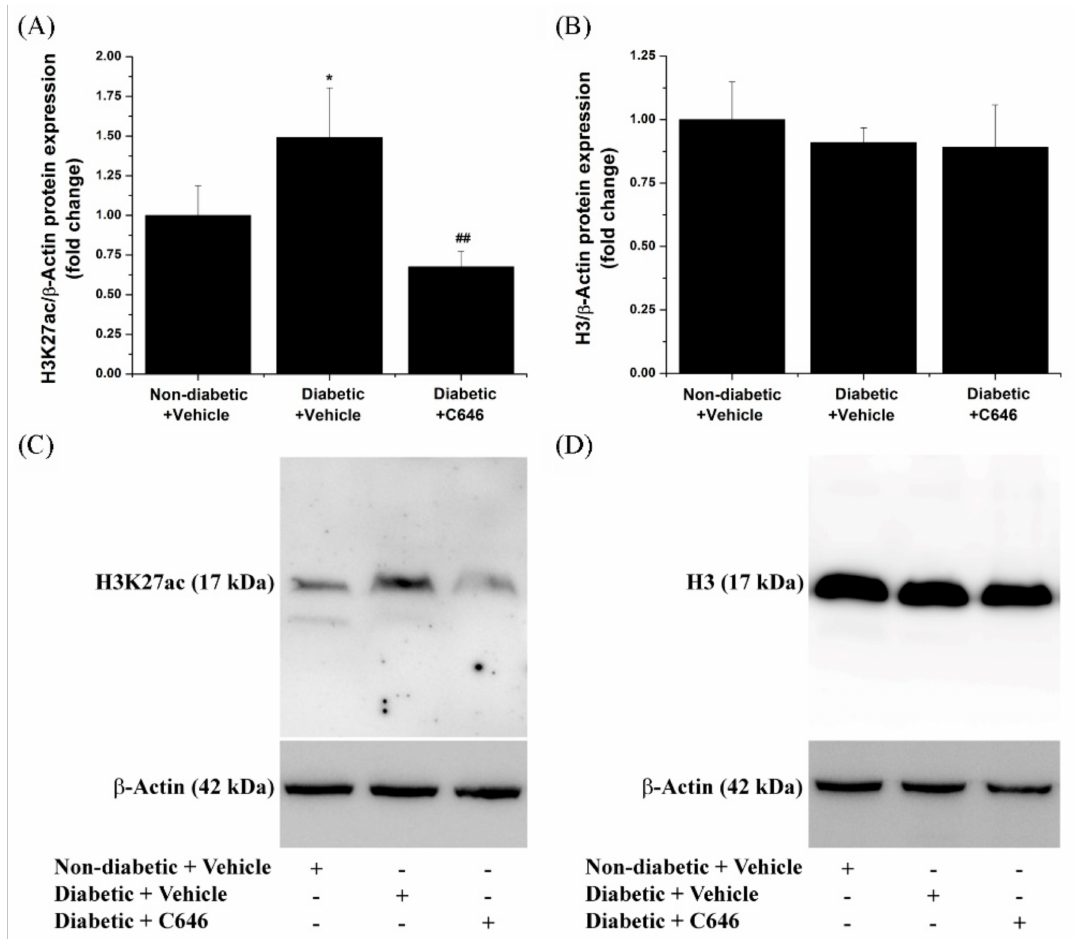
Figure 2. Pharmacological inhibition of histone acetyltransferase p300/CBP suppresses the up-regulation of H3K27ac level in the kidney of diabetic mice. n = 3–4, * p < 0.05, p -value taken in relation to non-diabetic + vehicle condition; ## p < 0.01, p -value taken in relation to diabetic + vehicle condition. ( A , B ) Densitometric analysis of the Western blot data showing the modulation of overall renal H3K27ac and H3 protein expression levels in each animal group. ( C , D ) Representative immunoblots depicting the relative expression levels of H3K27ac and H3 in the whole kidney protein